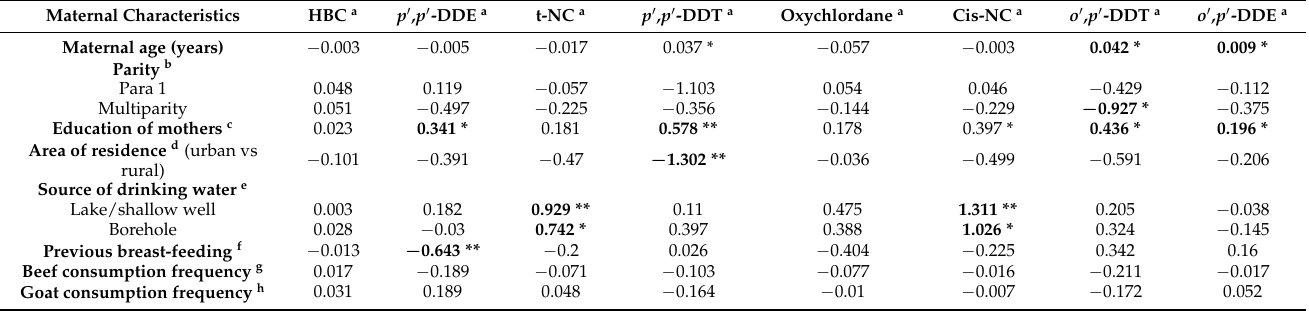
Table 3. Multivariable linear regression of POP concentrations in blood serum and maternal